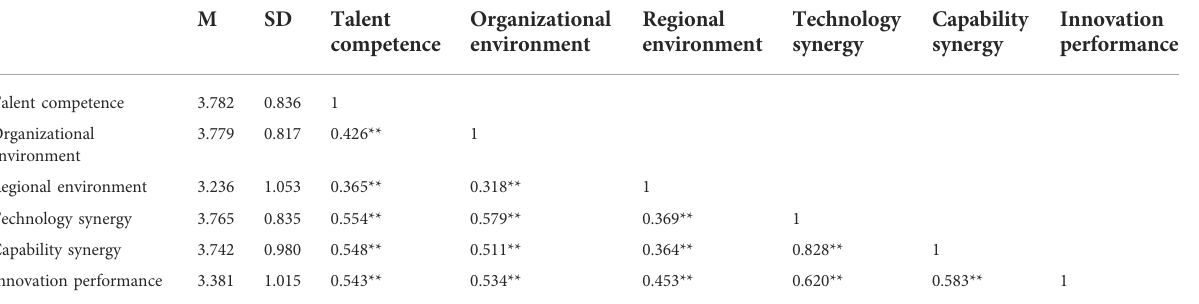
TABLE 2 Correlation analysis. M SD Talent